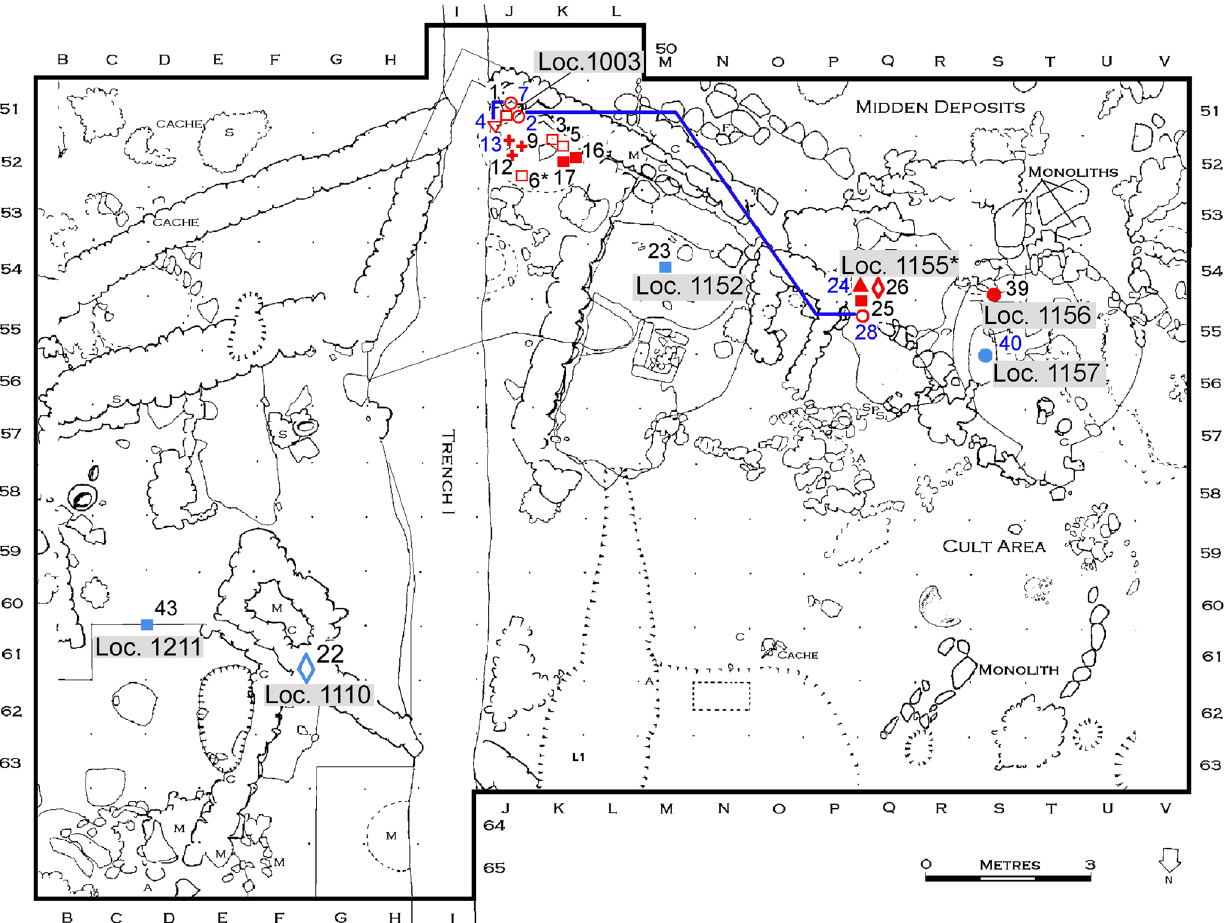
Fig 2. Plan of Kfar HaHoresh (modified after [22]). Loci with human remains analyzed in this study: blue numbers indicate related individuals in Group A/B, blue line indicates individuals related according to the distance analysis. * Loc. 1155 includes Loci 1352, 1353 and 1373. Blue colored = middle occupational period red colored = late occupational period filled / unfilled square = male / male? Adult; filled / unfilled circle female/female? Adult; unfilled diamond = adult indet; filled / unfilled triangle pointing upwards = male/male? juvenile, filled / unfilled triangle pointing downwards = female/female? Junvenile; cross = infans.